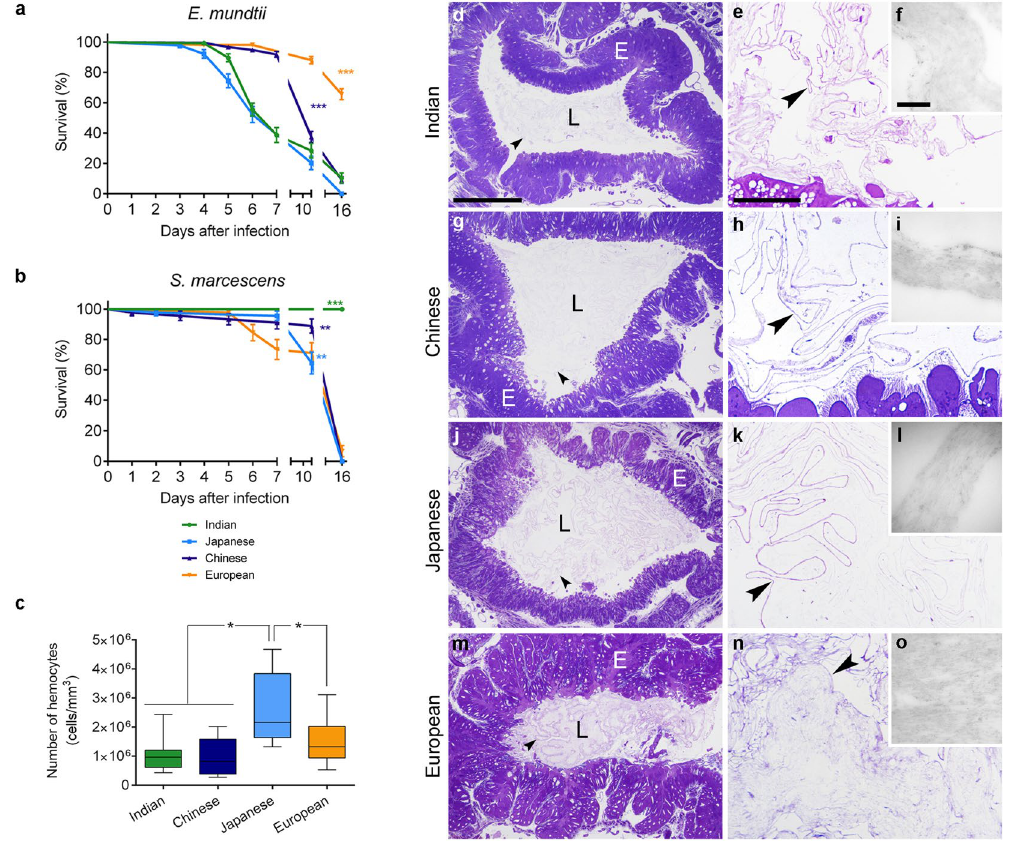
Figure 1. Differential sensitivity to E . mundtii and S . marcescens of the four B . mori strains. Survival curves (mean %s ± SEM) of the four B . mori strains, infected with E . mundtii ( a ) or S . marcescens ( b ). ( a ) E . mundtii strain sensitivity in Mantel-Cox test: Japanese = Indian (p = 0.11, not significant, ns) > Chinese (p < 0.0001) > European (p < 0.0001). ( b ) S . marcescens strain sensitivity in Mantel-Cox test: Japanese vs European (p = 0.51, ns); Japanese vs Chinese (p = 0.013); European vs Chinese (p = 0.26, ns); Indian vs all the other strains (p < 0.0001). *** p < 0.0001, ** p = 0.013. ( c ) Number of hemocytes (Median and 10–90 percentiles of ten samples per strain) in the four B . mori strains, at the moment of the oral infection. One-way ANOVA revealed significant differences in the Japanese stain compared to all the other strains (F 3,36 = 8.86, p = 0.0002; * Newman-Keuls post - hoc test p < 0.05). ( d – o ): Morphology of intestinal epithelia and PMs of the Indian ( d – f ), Chinese ( g – i ), Japanese ( j – l ) and European ( m – o ) strains. Light ( d , e , g , h , j , k , m , n ) and transmission electron ( f , i , l , o ) microscopy images of midgut cross sections. ( e , h , k , n ) are details at higher magnification of ( d , g , j , m ),